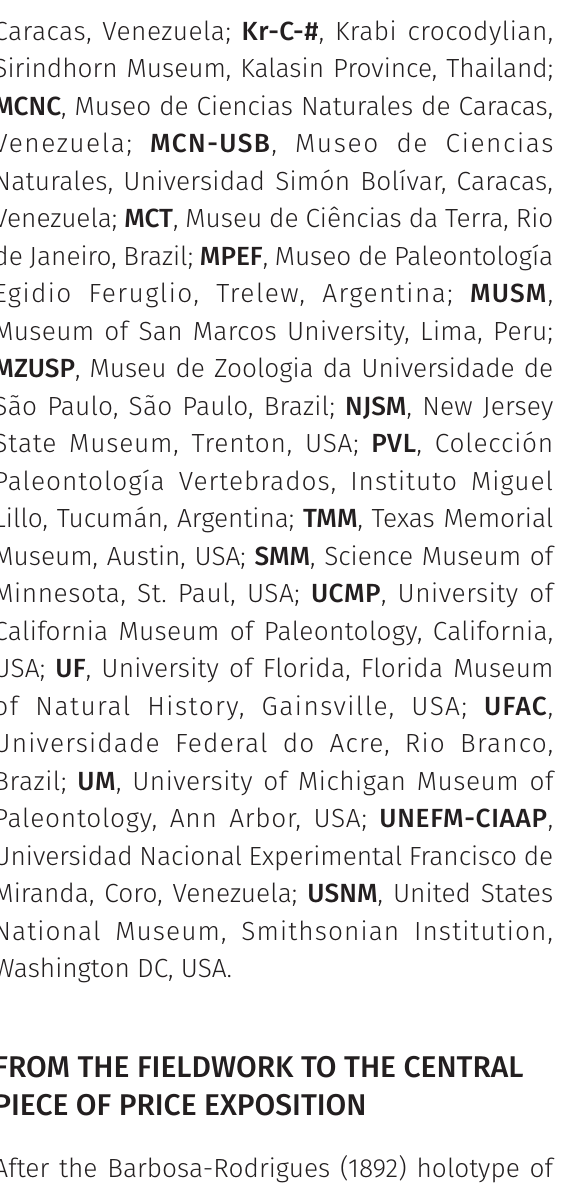
Figure 1: Purussaurus brasiliensis specimens. The holotype, modified reproduction of original plate drawings of Barbosa-Rodrigues (1892), in a) dorsal (occlusal) view; b) ventral view; and, c) medial view; and, d) schematic drawing of DGM 527-R based on original work of Price (1967). Scale bar: 20